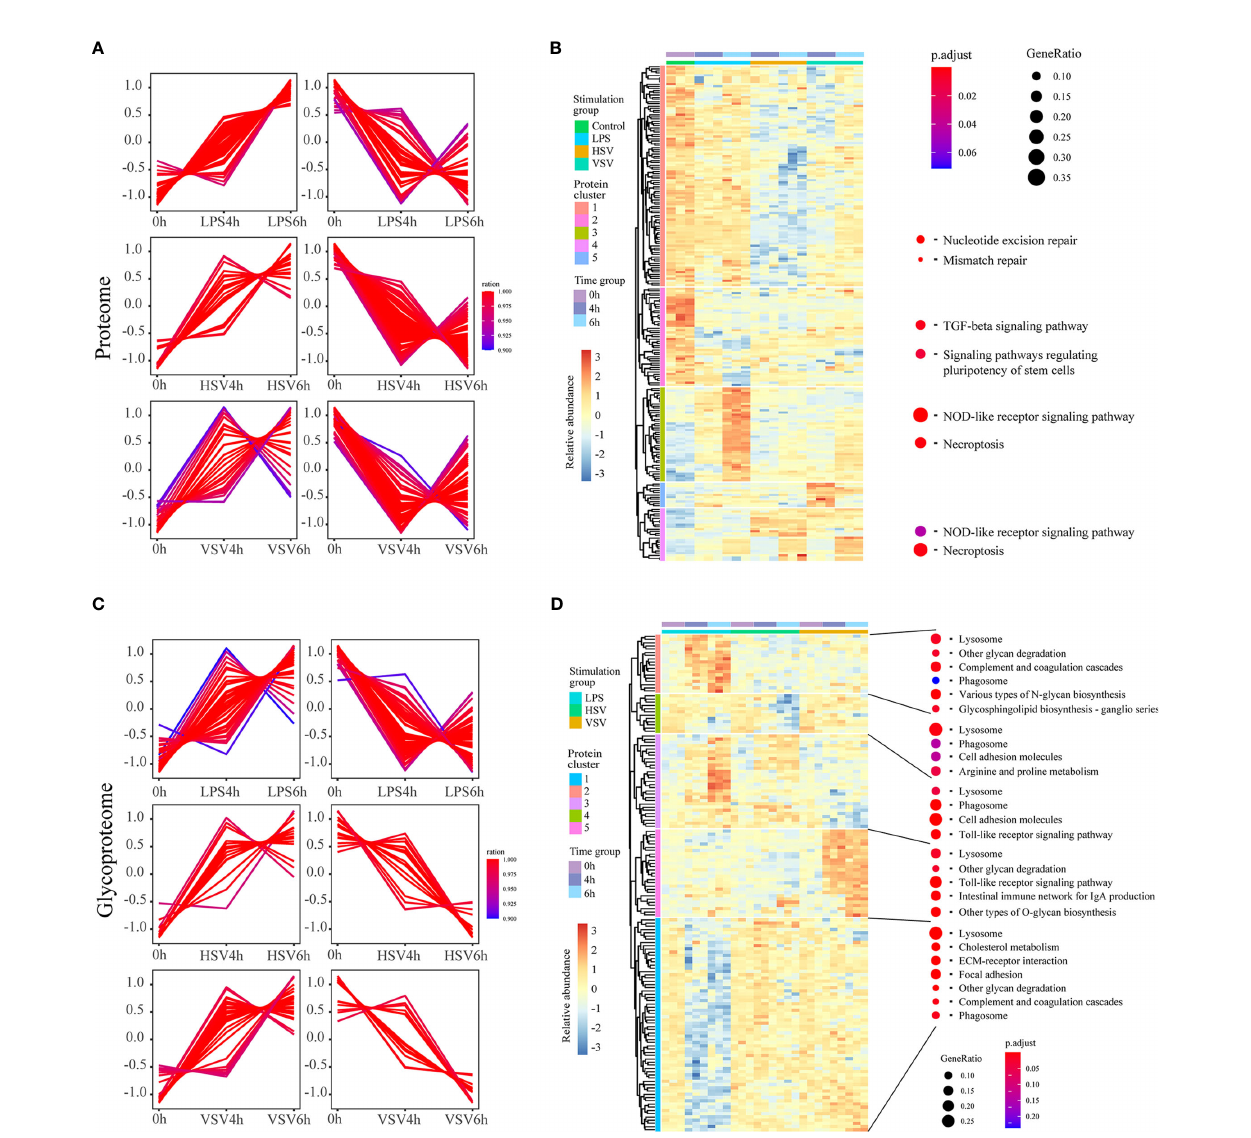
FIGURE 3 | Regulatory groups and functional differences. Proteins with consistently upregulated and downregulated expression in proteomic (A) and glycoproteomic pro fi ling (C) under these three different stimulations. These continuously changed proteomes were further clustered in a heatmap and are presented with related GO terms (B, D)